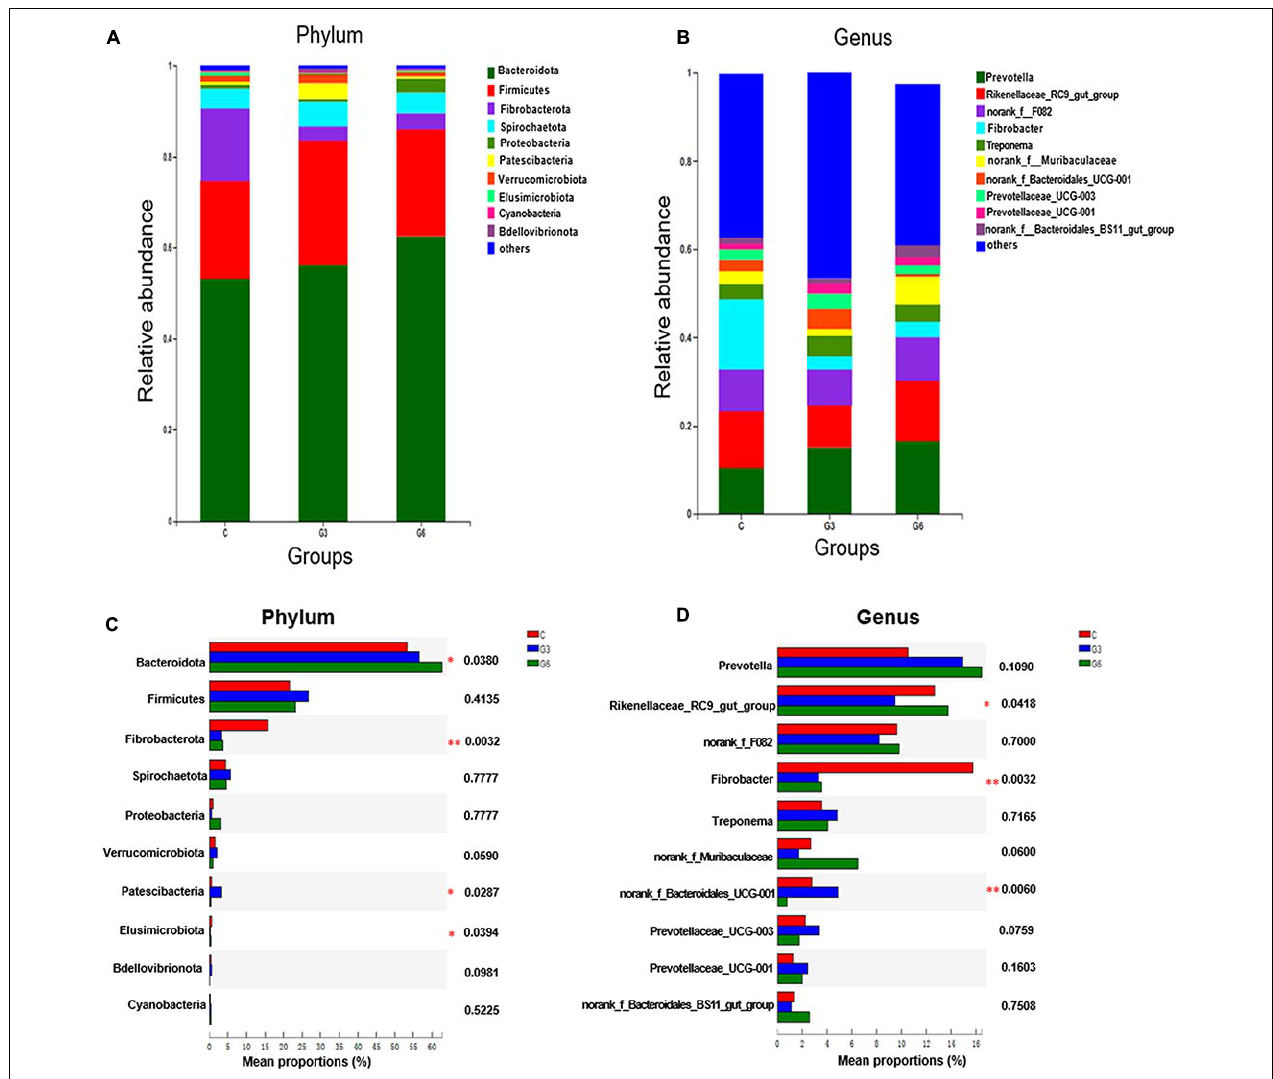
FIGURE 2 | Relative rumen microbiota abundance at (A,C) phylum and (B,D) genus levels in the grass-fed (C), grain-fed for 3 months (G3), and grain-fed for 6 months (G6) yaks experimental groups. * p < 0.05; ** p <